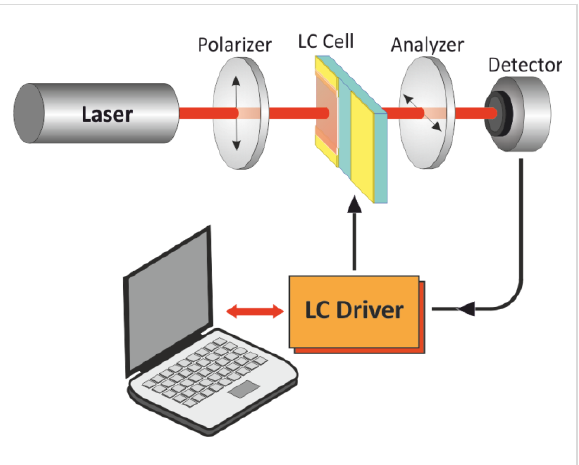
Figure 4: Schematic of the liquid crystal characterization experiment.